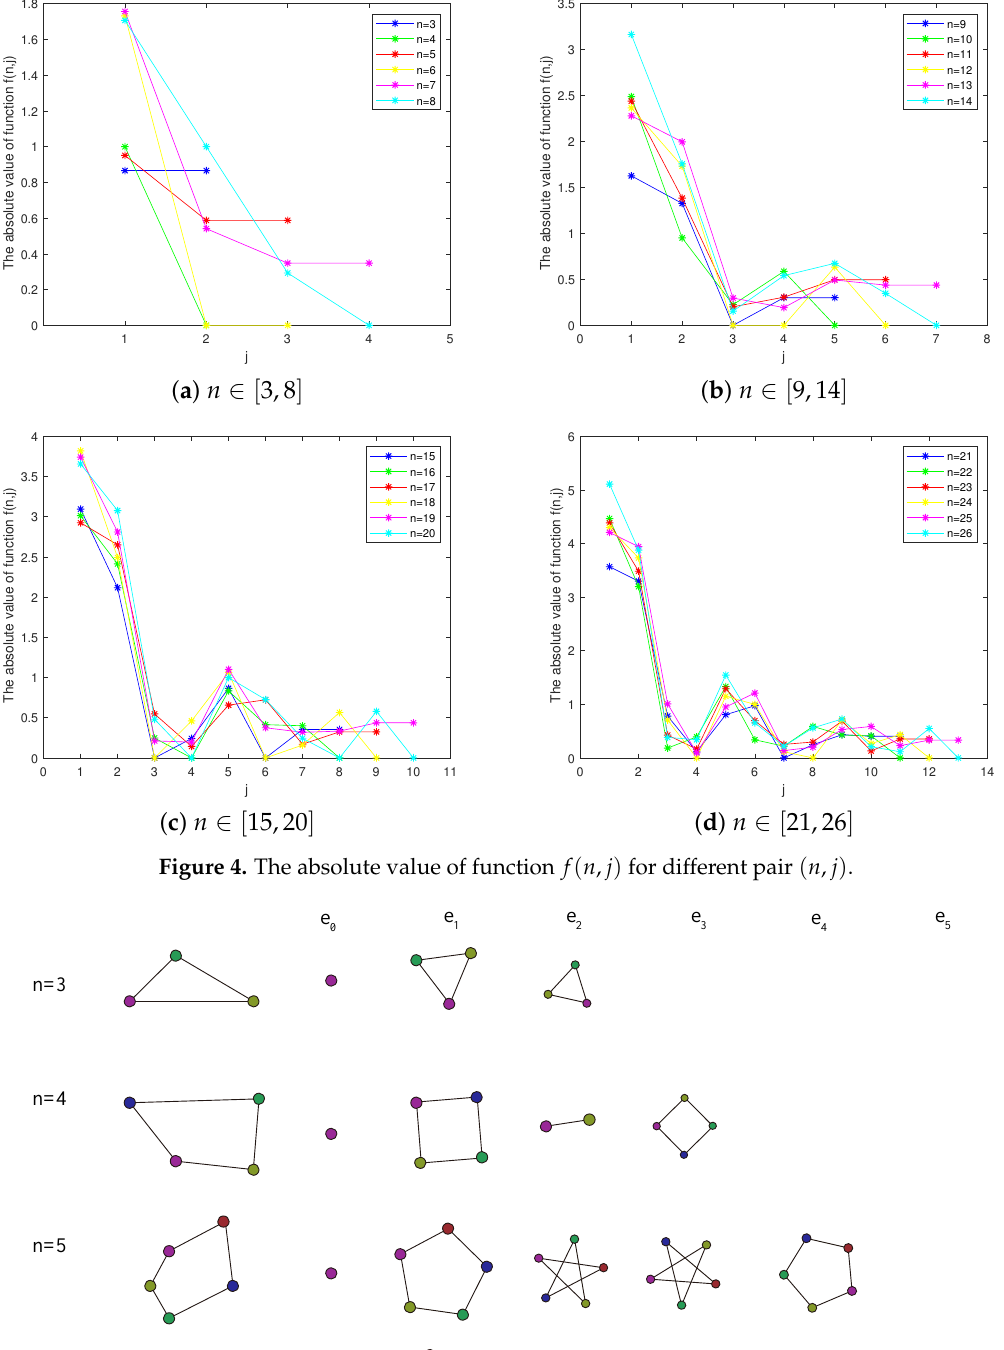
Figure 5. Eigenpolygon decomposition of a triangular, quadrilateral, pentagonal and hexagonal element.